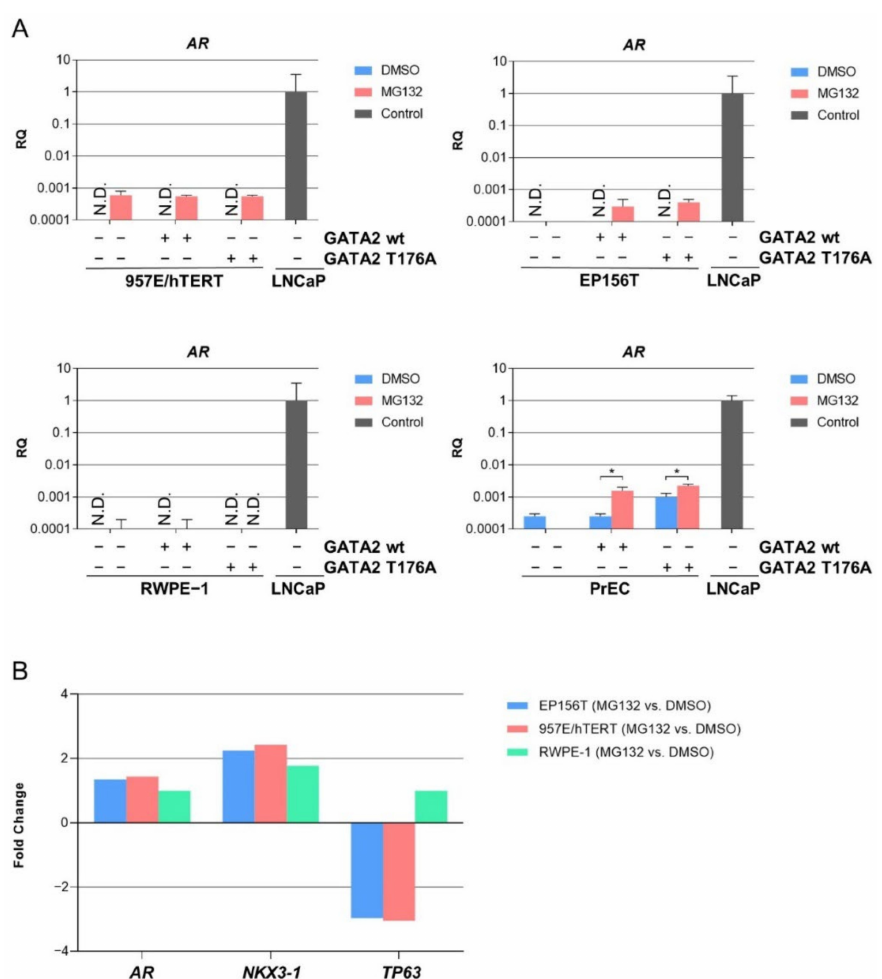
Figure 3. AR mRNA proteasome-mediated expression is present in different TA cells. ( A ). The basal- like TA cells were split once 48 h post-transduction and treated with 10 µ M MG132 for 8 h before being harvested. qPCR of 957E/hTERT cells, EP156T cells, RWPE-1 and PrEC cells. LNCaP cells were used as positive control without MG132 treatment. Error bars represent standard error of the mean expression level (RQ) based on the RQmin/max of 95% confidence level. N.D. = not detected. * p ≤ 0.05 by using one-way ANOVA followed by Sidak’s multiple comparisons test with 95% confi- dence interval. ( B ) EP156T, 957E/hTERT and RWPE-1 cells were treated with 10 µ M of MG132 for 6 h. The corresponding control cells were treated with DMSO. Total RNA was subjected to whole- genome microarray analyses. AR was significantly induced only in 957E/hTERT MG132-treated cells (FDR = 0.12) with FDR = 17 in MG132-treated EP156T and RWPE-1 cells. Significant expressions showed FDR = 0.0–0.81 for NKX3-1 and FDR = 0.0–0.23 for TP63 in EP156T and 957E/hTERT